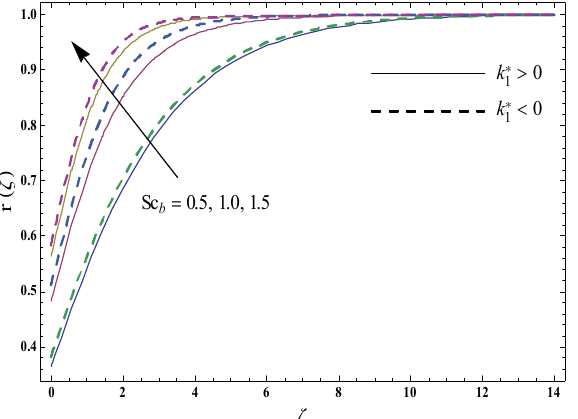
Figure 9. Variations of concentration for thermophoresis parameter when N b = 0.2, Sc = Pr = 1.0 and M = 0.2.